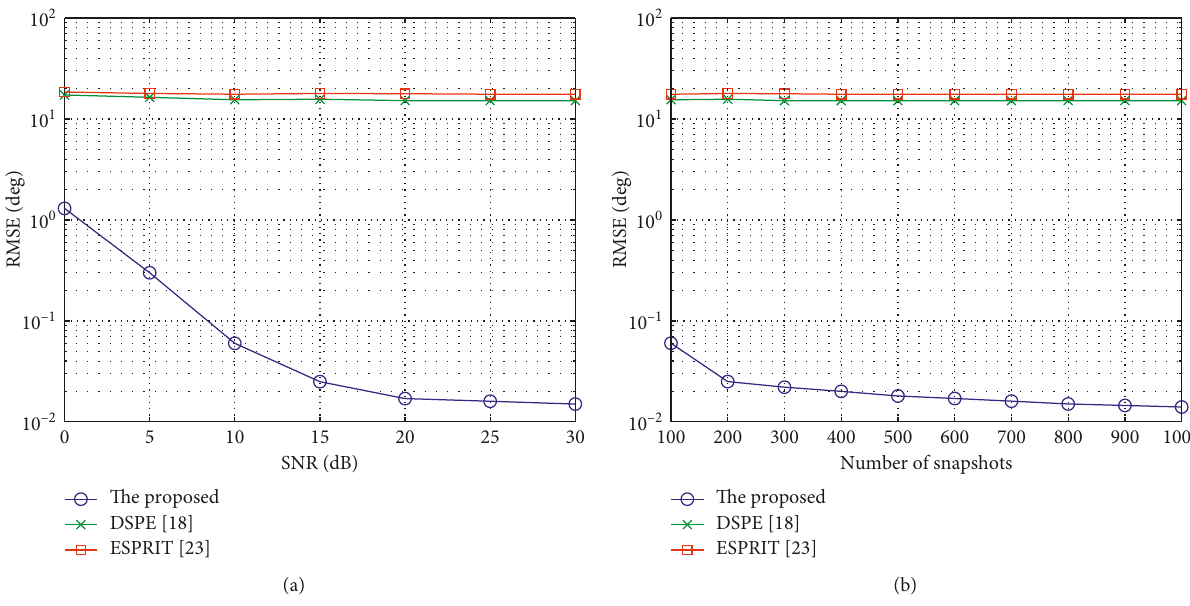
Figure 4: (a) RMSE estimated by three algorithms versus SNR; (b) RMSE estimated by three algorithms versus number of